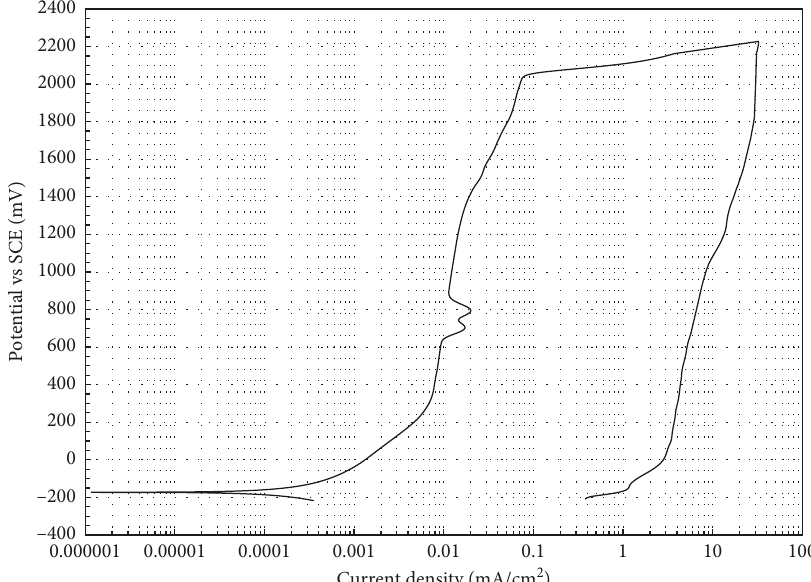
Figure 3: Cyclic polarization curve for Ti6Al4V India in 0.9% NaCl solution at 37 ° C (0.1667mVs − 1